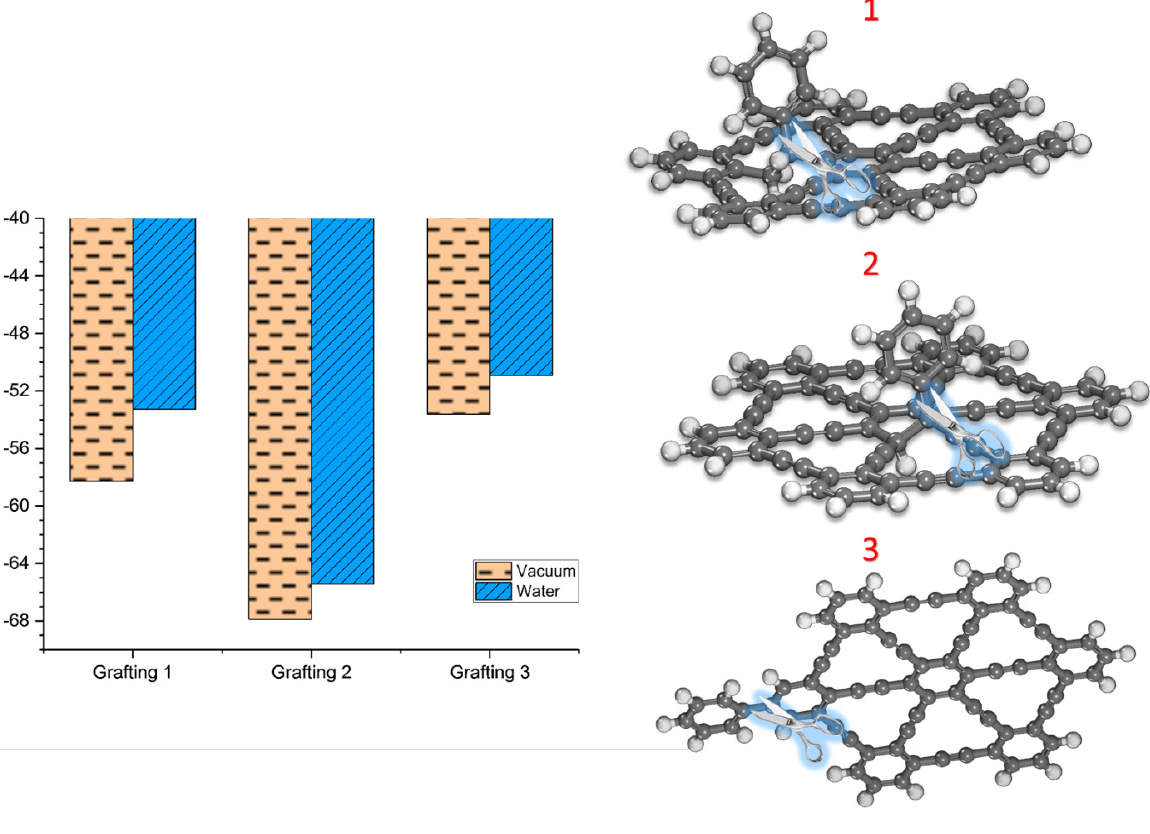
Figure 5: BDEs computed in: vacuum and water (COSMO) for the bonding of phenyl- radicals on 3 distinctive grafting position onto Graphyne surface.